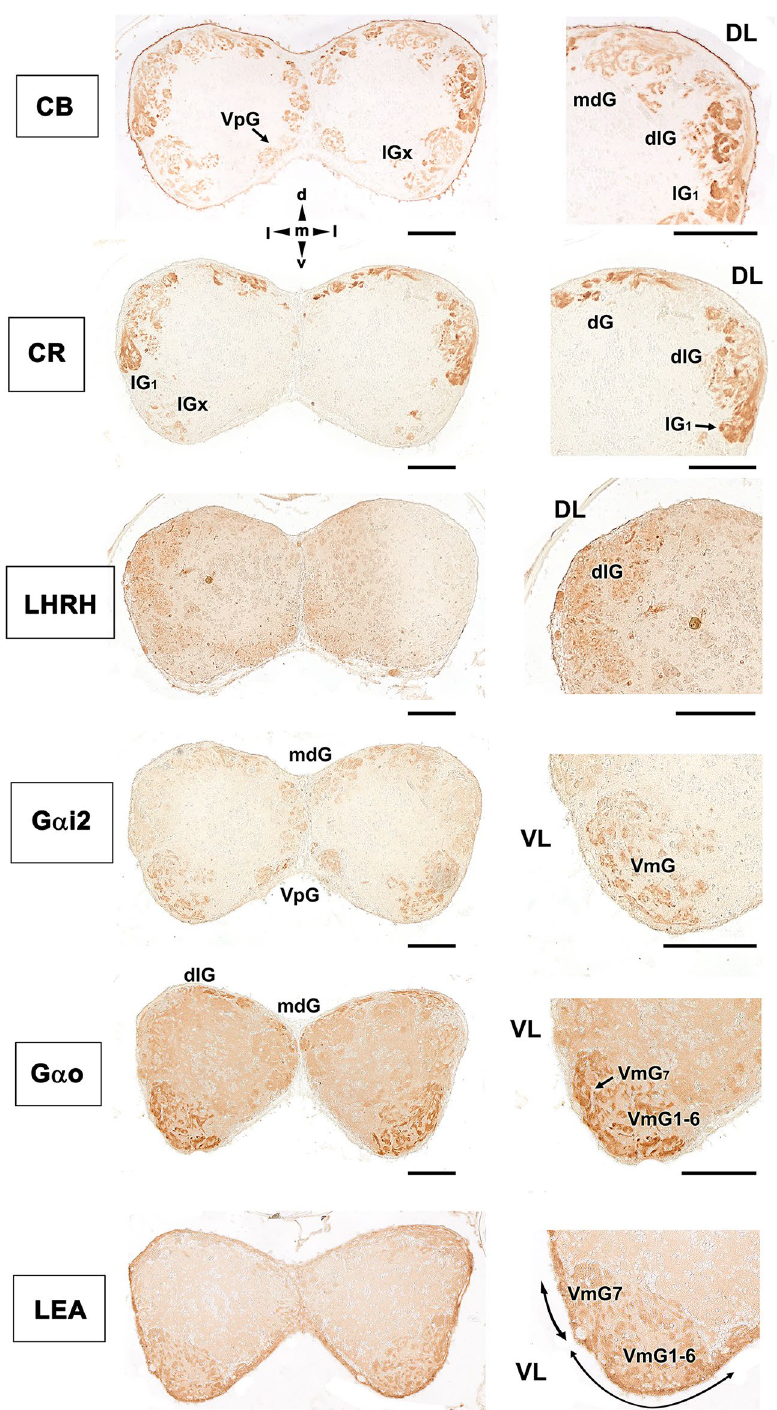
Figure 6. Immunohistochemical and histochemical labelling of the zebrafish olfactory bulb. Transverse sections through the central area of the olfactory bulb showing immunoreactivity with the antibodies anti-CB, anti-CR, anti-LHRH, anti-Gαi2, anti-Gαo and LEA lectin labelling. Calcium-binding proteins (CB and CR) are both mainly expressed in the dorsal (dG), dorsolateral (dlG) and lateral (lGx, lG 1 ) glomeruli. Additionally, calbindin is also expressed in glomeruli belonging to the mediodorsal part of the bulb (mdG) and, with less intensity, in the ventral posterior area (VpG). LHRH is expressed in the dorsolateral glomeruli. Both anti G-proteins show a similar pattern, with an intense labelling in the ventromedial glomerular (VmG) area, stronger in the case of Gαo. Additionally, anti-Gαi2 marks glomeruli belonging to the ventral posterior cluster (VpG). LEA labelling is mainly circumscribed to the ventral region. DL, dorsolateral; VL, ventrolateral; dG, dorsal glomeruli; dlG, dorsolateral glomeruli; lG 1 , lateral glomerulus 1; lGx, lateral cluster of glomeruli; mdG, mediodorsal glomeruli; VmG 1-6 , ventromedial glomeruli 1–6; VmG 7, ventromedial glomerulus 7; VpG, ventral posterior glomeruli; d, dorsal; l, lateral; m, medial; v, ventral. Scale bars: 100